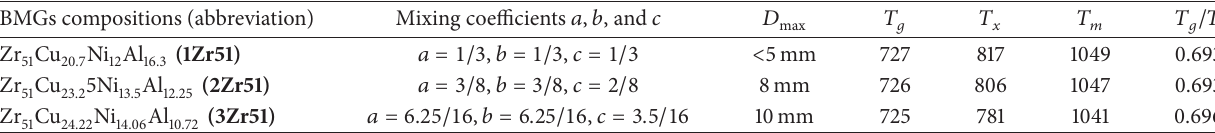
Figure 3: The XRD (a) and SEM-BSE (b) patterns for as-cast 3Zr51 sample with the diameter of 10 mm. Table 1: The new alloy compositions, abbreviations, adjustment of mixing constants, critical sizes 𝐷 max , and thermal parameters for the Zr-Cu-Ni-Al alloys.